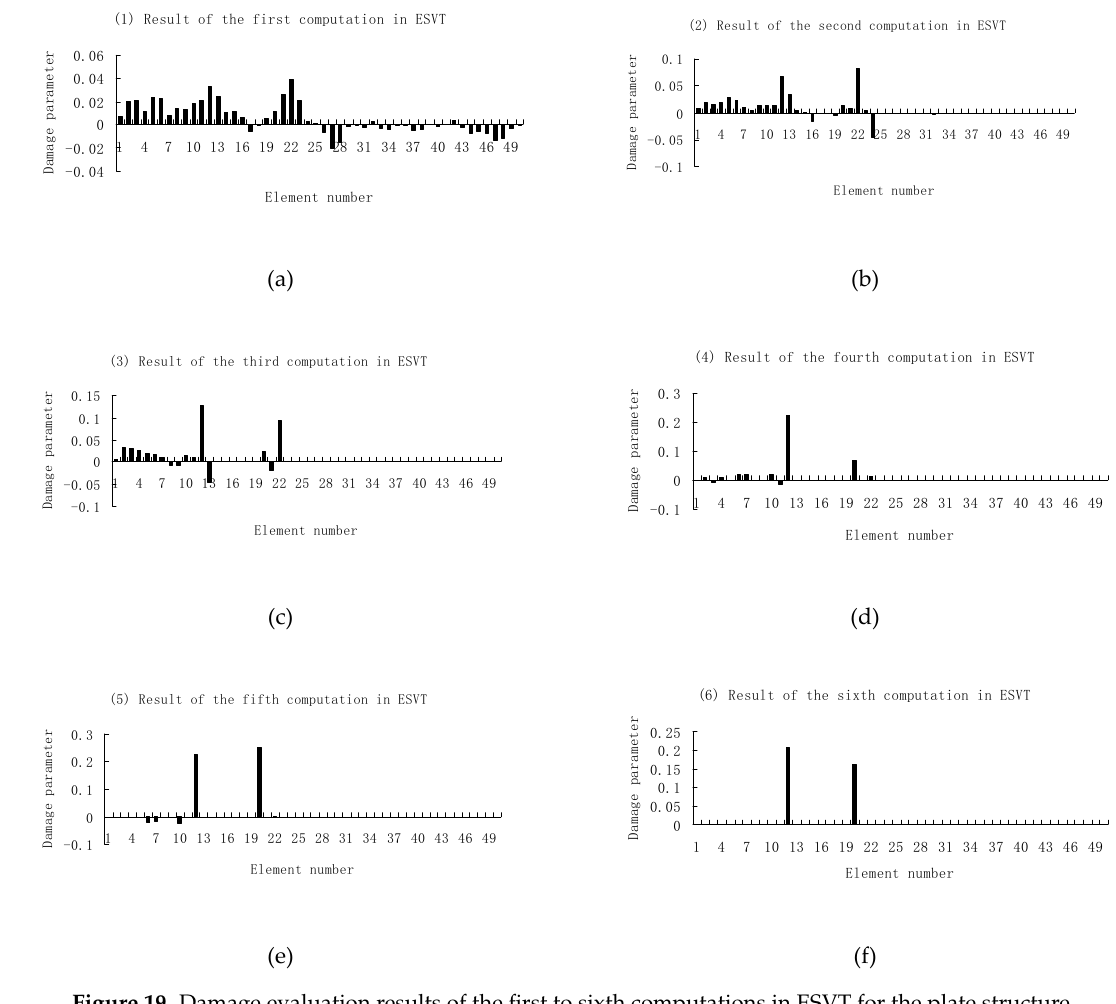
Figure 19. Damage evaluation results of the first to sixth computations in ESVT for the plate structure. ( a ) Result of the first computation in ESVT; ( b ) Result of the second computation in ESVT; ( c ) Result of the third computation in ESVT; ( d ) Result of the fourth computation in ESVT; ( e ) Result of the fifth computation in ESVT; ( f ) Result of the sixth computation in ESVT.